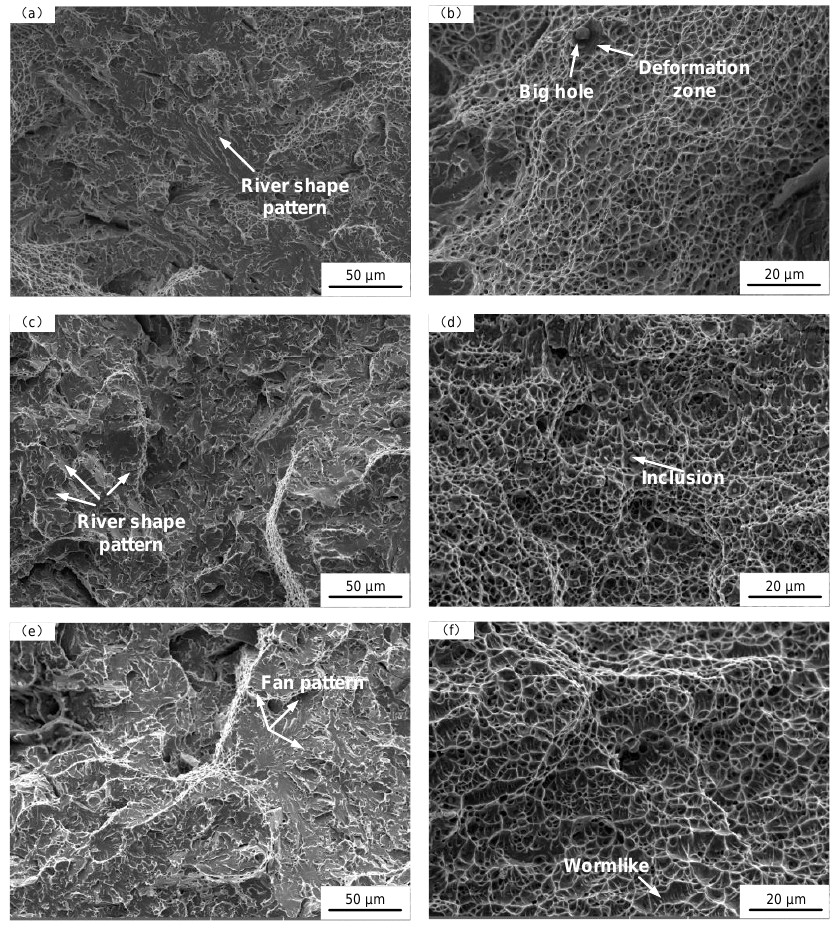
Figure 3. SEM images of fracture surfaces of deposited metal under different heat inputs: ( a , b ) 1.45 Figure 3. SEMimagesoffracturesurfacesofdepositedmetalunderdifferentheatinputs: ( a , b ) 1.45 kJ/mm; kJ/mm; ( c , d ) 1.78 kJ/mm; ( e , f ) 2.31 kJ/mm. ( c , d ) 1.78 kJ/mm; ( e , f ) 2.31